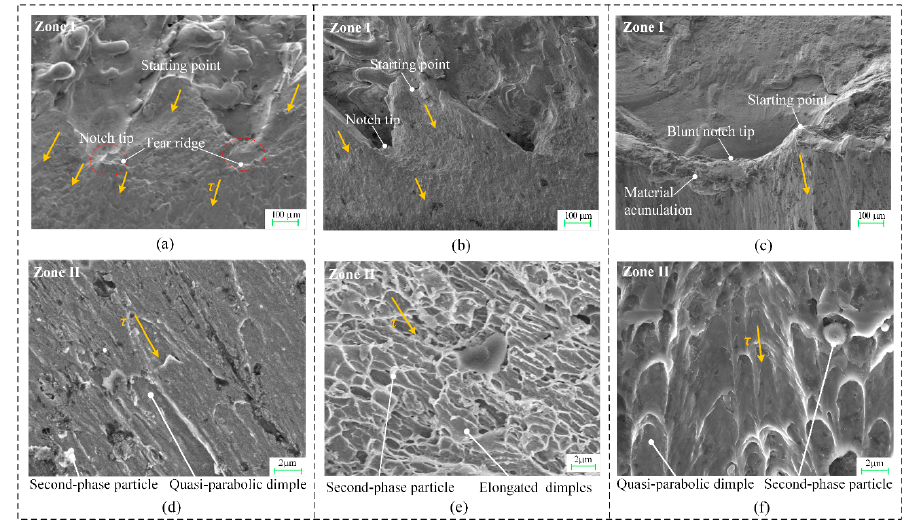
Q235 bar. ( b ) Laser-affected zone I of 40Cr bar. ( c ) Laser-affected zone I of 304 bar. ( d ) Main fracture zone II of Q235 bar. ( e ) Main fracture zone II of 40Cr bar. ( f ) Main fracture zone II of 304 bar.